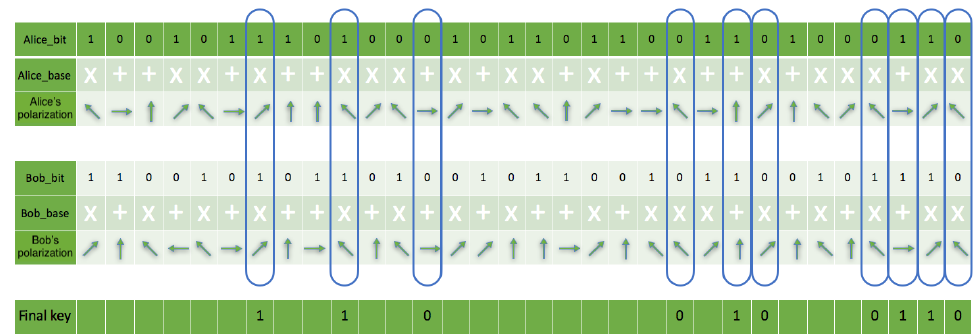
Figure 13. This is a figure showing a sample of the sender and receiver comparing each other’s selected results.